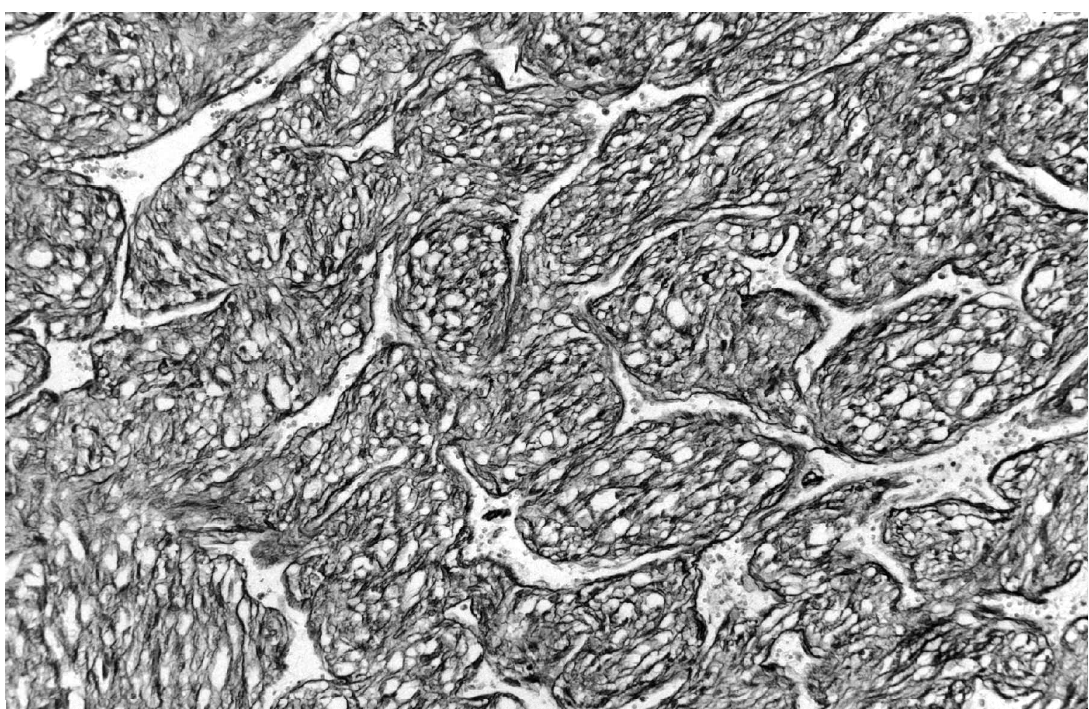
Fig. 3. Reticulin stain showing that reticular ® bers surround each individual neoplastic cells (180 3